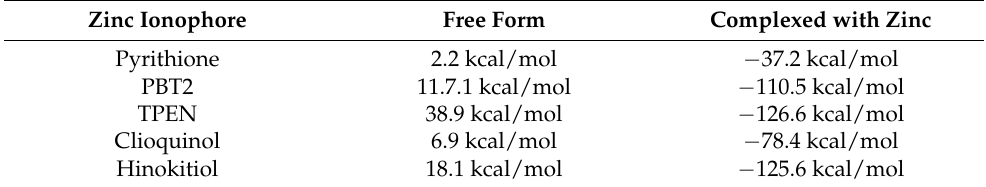
Table 1. Molecular mechanics computed energy E of free forms of zinc ionophores and when forming complexes with zinc cations. Zinc Ionophore Free Form Complexed with Zinc Pyrithione 2.2 kcal/mol − 37.2 kcal/mol PBT2 11.7.1 kcal/mol − 110.5 kcal/mol TPEN 38.9 kcal/mol − 126.6 kcal/mol Clioquinol 6.9 kcal/mol − 78.4 kcal/mol Hinokitiol 18.1 kcal/mol − 125.6 kcal/mol